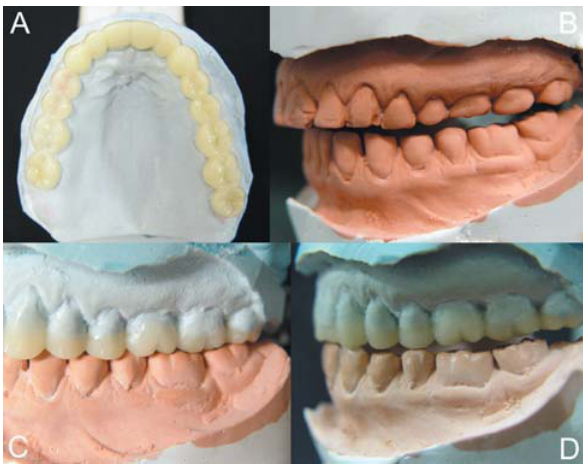
FIGURE 3- Cast models mounted in centric relation position. A: waxed model, upper view; B: space created to esthetic restorations; C: occlusion pattern obtained by waxing up; D: testing lateral guidance on waxed model